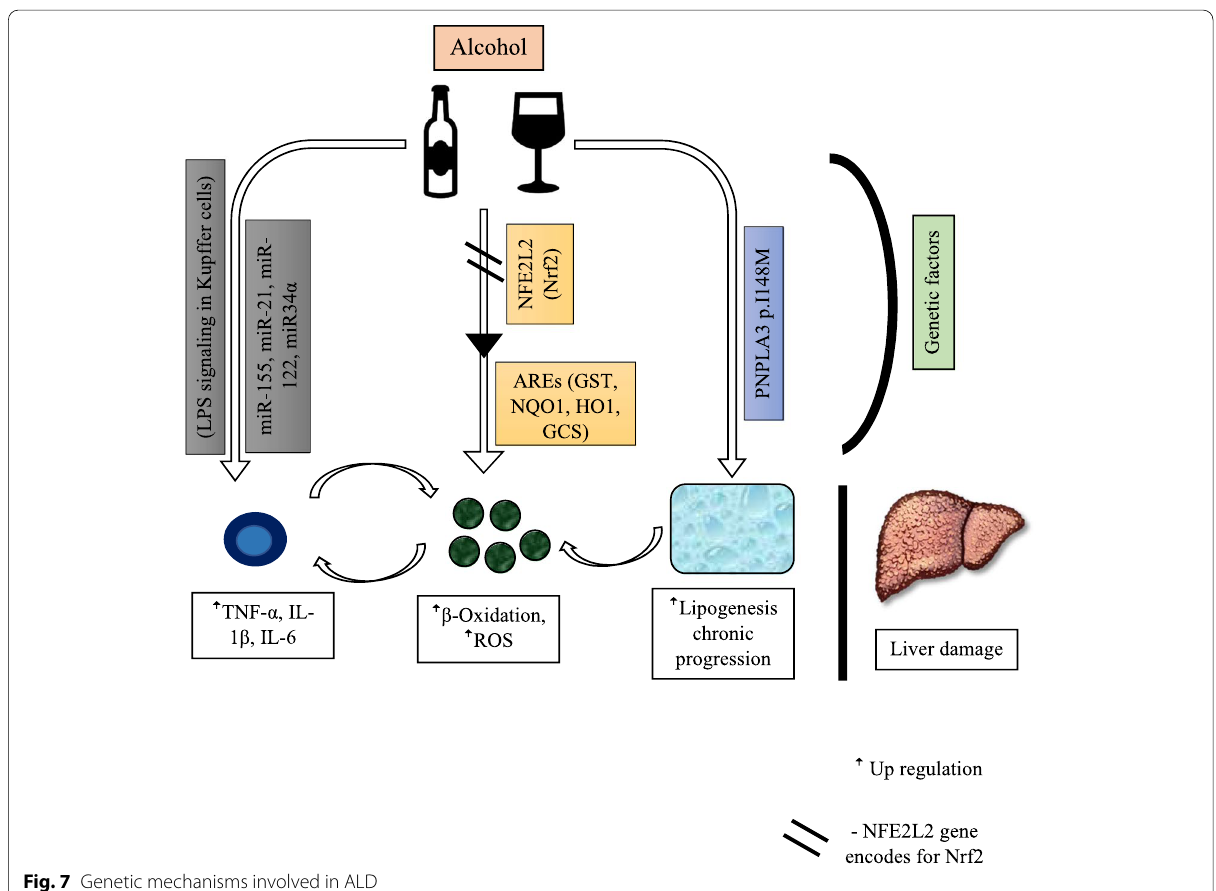
Fig. 7 Genetic mechanisms involved in